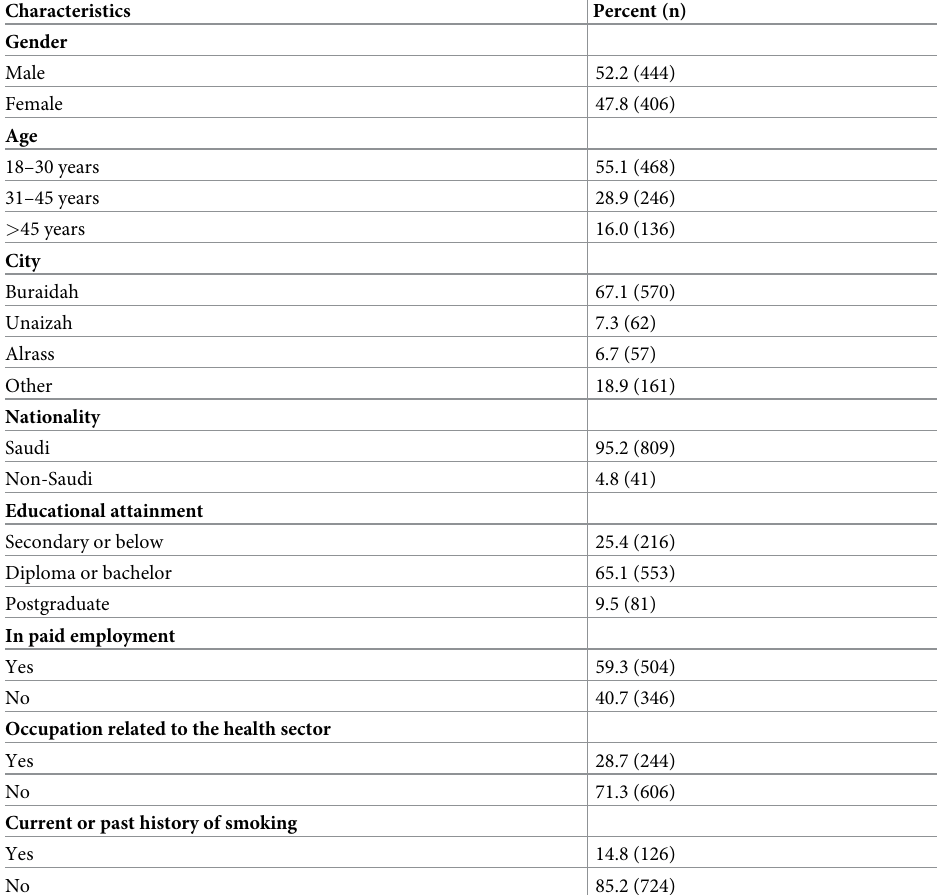
Table 1. Characteristics of the participants, prevalence, and predictors of respiratory allergies in Qassim, KSA, September–December 2020.